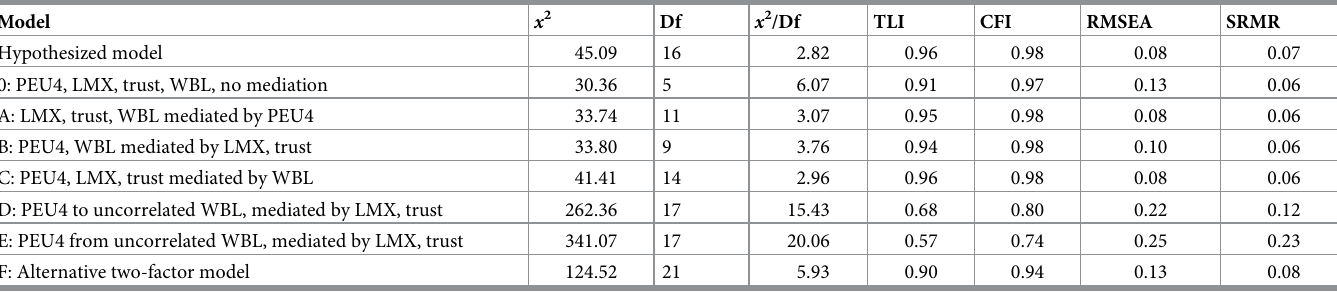
Table 9. Fit statistics for competing models for perceived evidence use (Study 5).